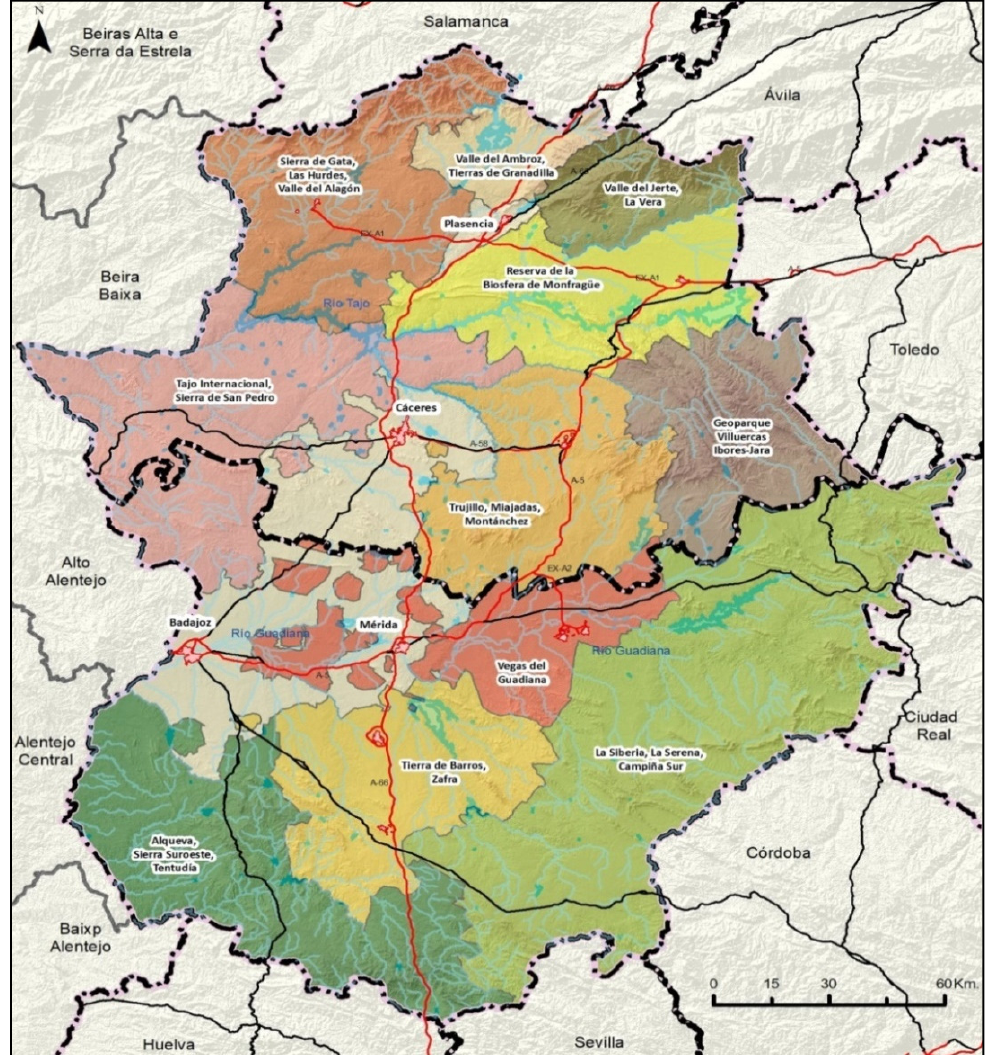
Figure 1. Tourist areas of Extremadura (Spain). Source: Tourism Observatory of Extremadura, Quarterly bulletin of tourism supply and demand in Extremadura Fourth-Quarter 2018 Document (14/2018). p. 78. https://www.viajarporextremadura.com/cubic/ap/cubic.php/doc/Guia-de-Extremadura-11.htm, accessed on 10 April 2021.